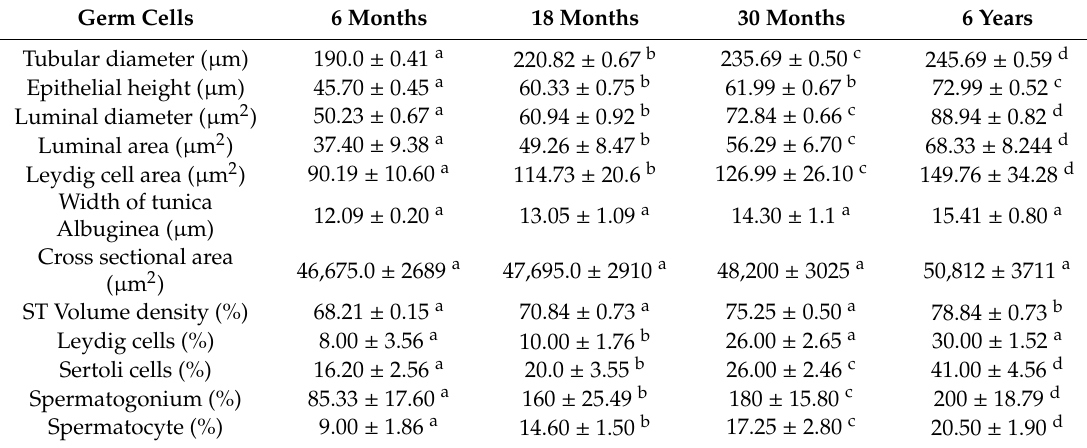
Table 3. Diameter ( µ m) of the seminiferous tubule and the number of cells in the testicles of di ff erent ages of yak (mean ±